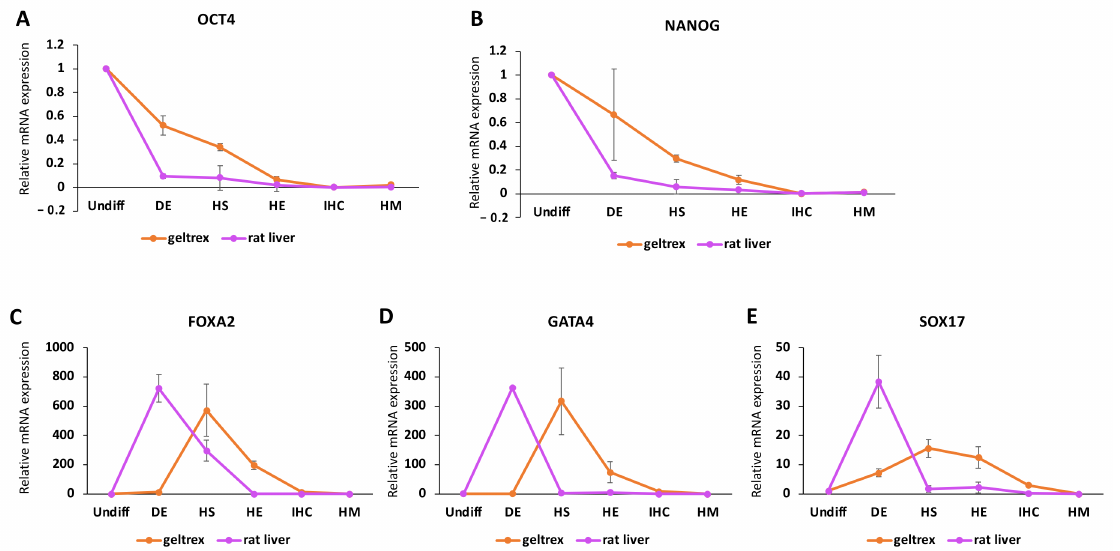
Figure 3. Changes in the expression patterns of pluripotency and endoderm markers in iPSCs throughout differentiation in native liver ECM. qRT − PCR analysis results showing the mRNA expression levels of ( A ) OCT4, ( B ) NANOG, ( C ) FOXA2, ( D ) GATA4, and ( E ) SOX17 relative to the respective expression levels in undifferentiated iPSCs throughout the differentiation in the geltrex and decellularized rat liver (rat liver) groups. For rat liver data, samples from three scaffolds at the DE, HS, HE, IHC, and IHC+ stages were analyzed. For geltrex data, at least three different differentiations at each stage were used in the